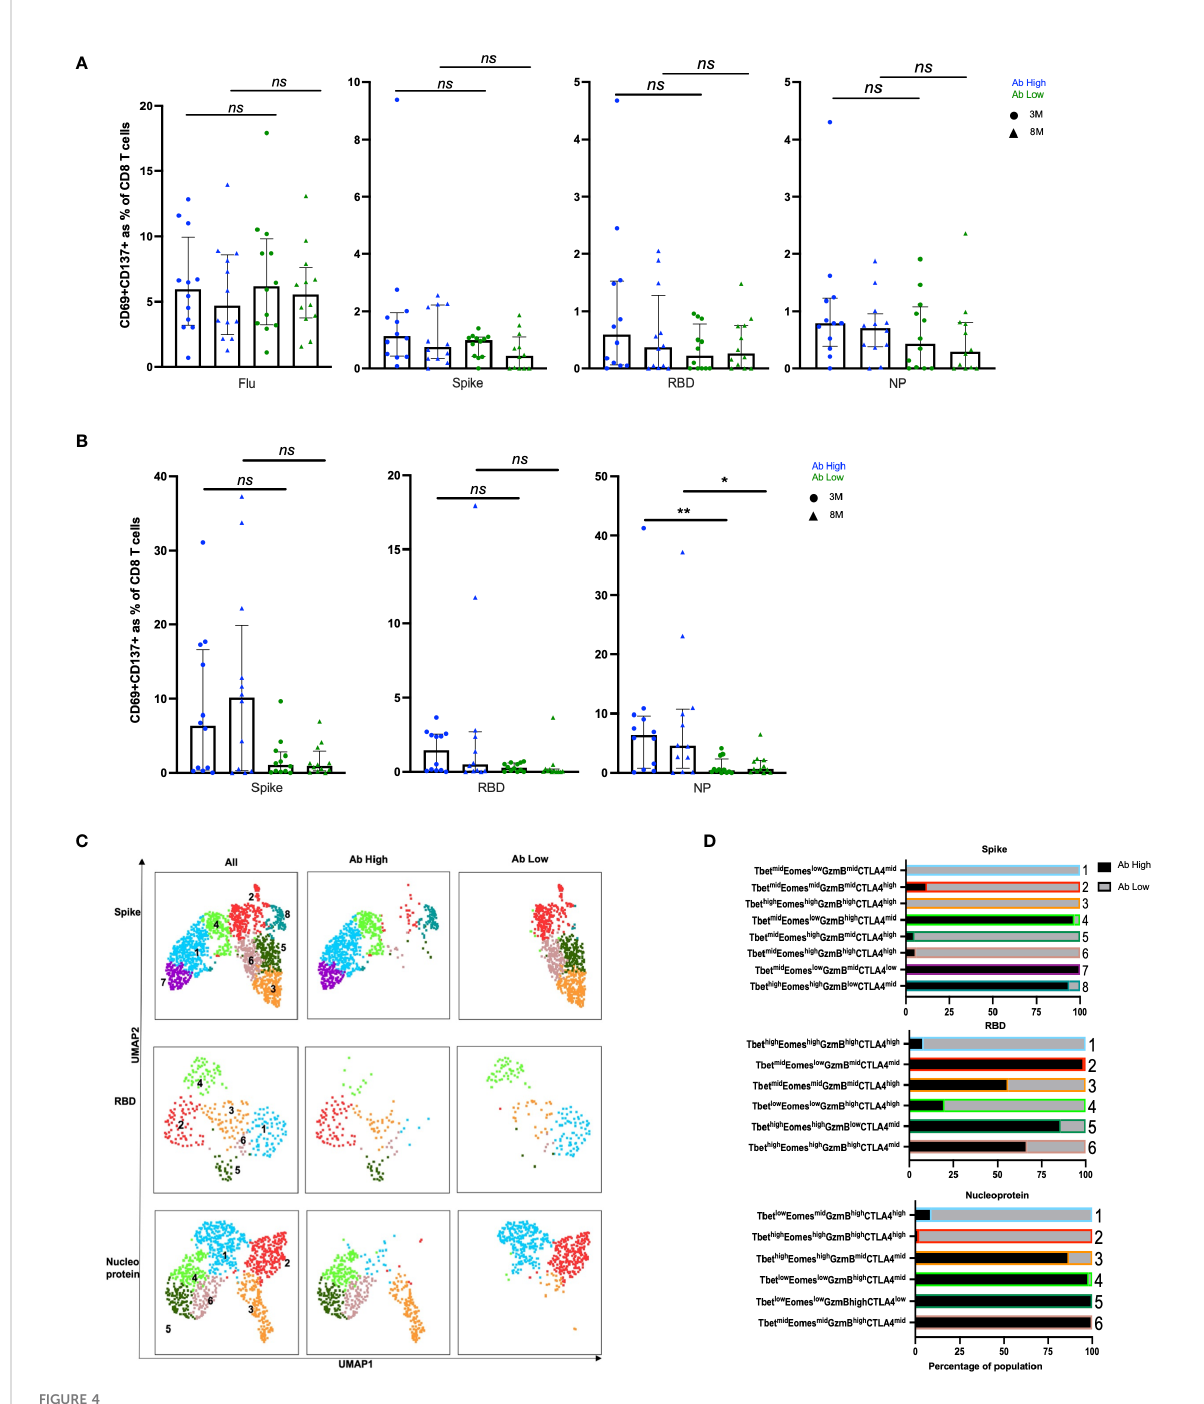
FIGURE 4 No difference in CD8 responses but presence of inhibitory receptors in Ab low subjects. (A) No difference between CD8 in Ab high and Ab low groups. (B) Higher frequency of NP proliferative CD8 T cells in Ab high group compared to Ab low. 3M (3 months) and 8M (8 months). Data shown as medians with interquartile ranges. (C) Representative UMAP of proliferated CD8 T cells; concatenated, ab high and ab low. (D) Presence of an inhibitory phenotype within cells of Ab low subjects. Colour and number of horizontal bar graphs match with UMAP clusters. Black columns (Ab high) and grey columns (Ab low). Two-tailed p values <0.05 were considered signi fi cant (*<0.05, **<0.01). Mann-Whitney T test used for unpaired samples. ns, not signi fi